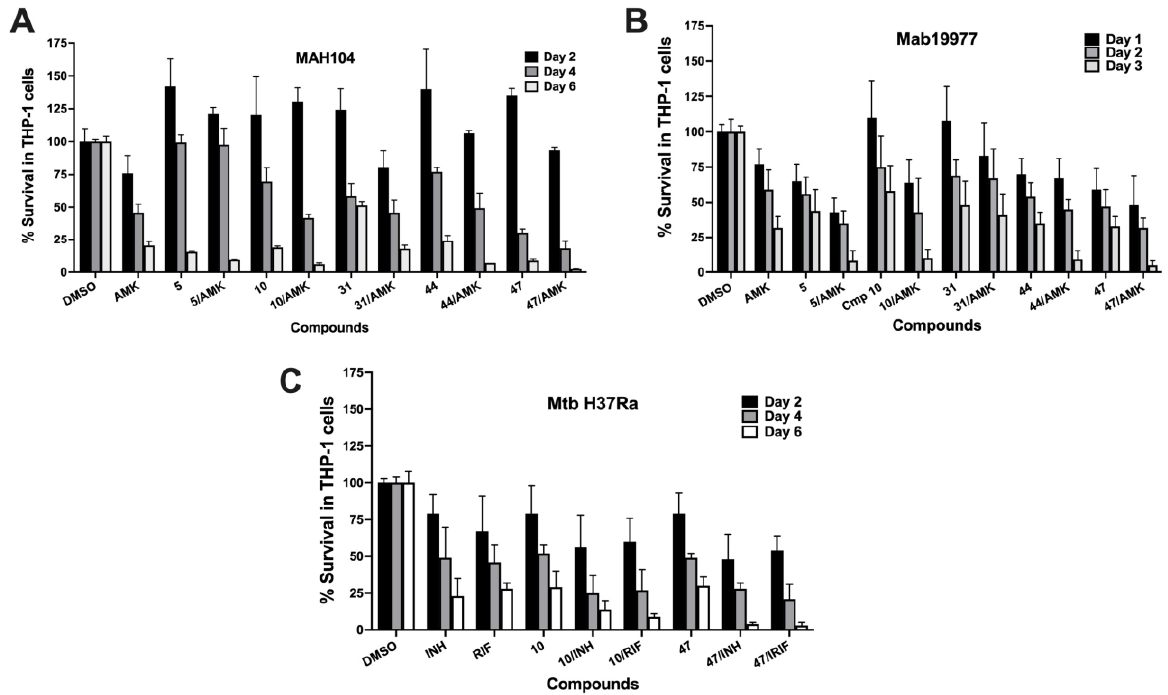
Figure 3. Time-kill dynamics of mycobacteria in THP-1 cells during combination treatment with “intracellular” compounds and antibiotics. ( A ) MAH104 survival rates in macrophages in